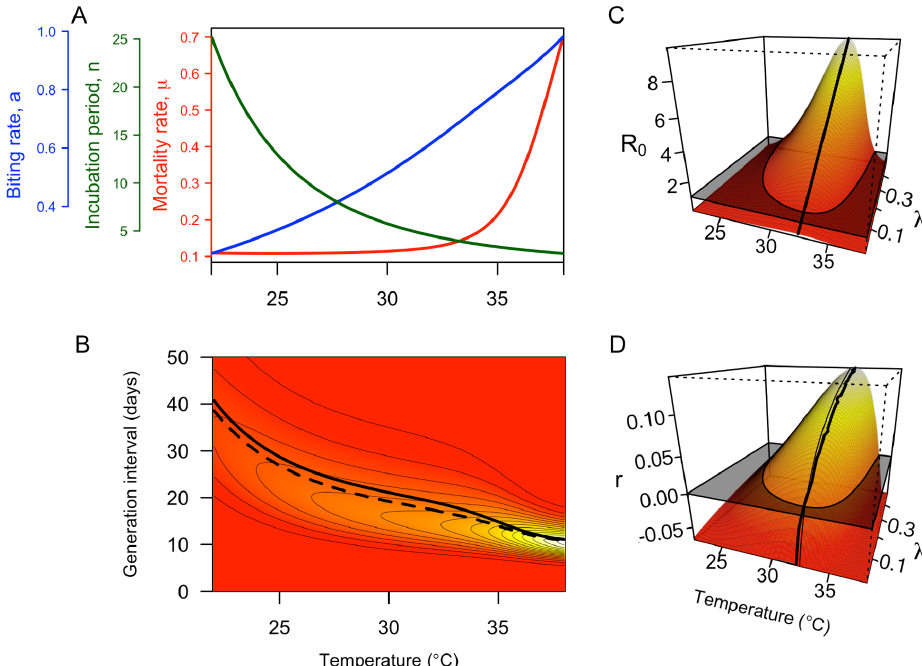
Fig 2. Relationships betweentemperatureand entomological parameters (A) and epidemiological quantities (B-D). The thick solid (dashed)line in B shows the mean (median)generationinterval at each temperature, and colors indicate the probabilitydensity of generationintervalsat a given temperature (red to yellow = low to high). Contoursshow probabilitydensity values in intervals of 0.05. Coloredsurfaces in C and D show how temperature and mosquitoemergence rate λ affect R 0 and r (red to yellow = low to high), respectively. Black planesin C and D indicate the combinations of temperature and λ values for which R 0 and r fall aboveor belowthresholdvalues (1 or 0, respectively). The thick black lines in C and D show the temperatures at which either R 0 or r is maximized for a given value of λ . For comparison, the thin line in D indicatestemperaturesat which R 0 is